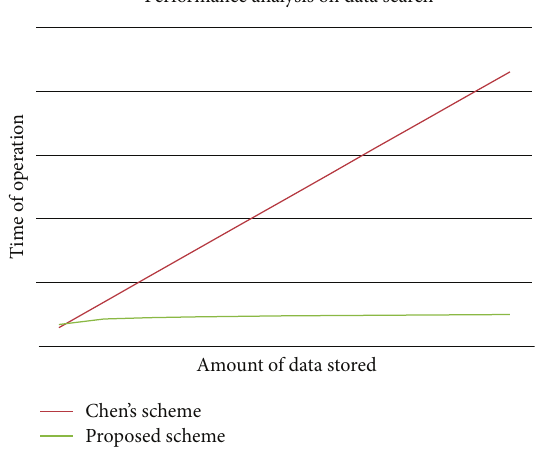
Figure 8: Storage